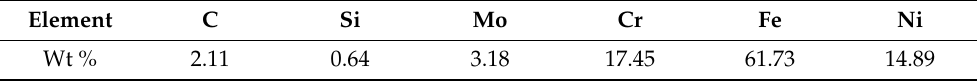
Table 5. Chemical composition of the steel femoral